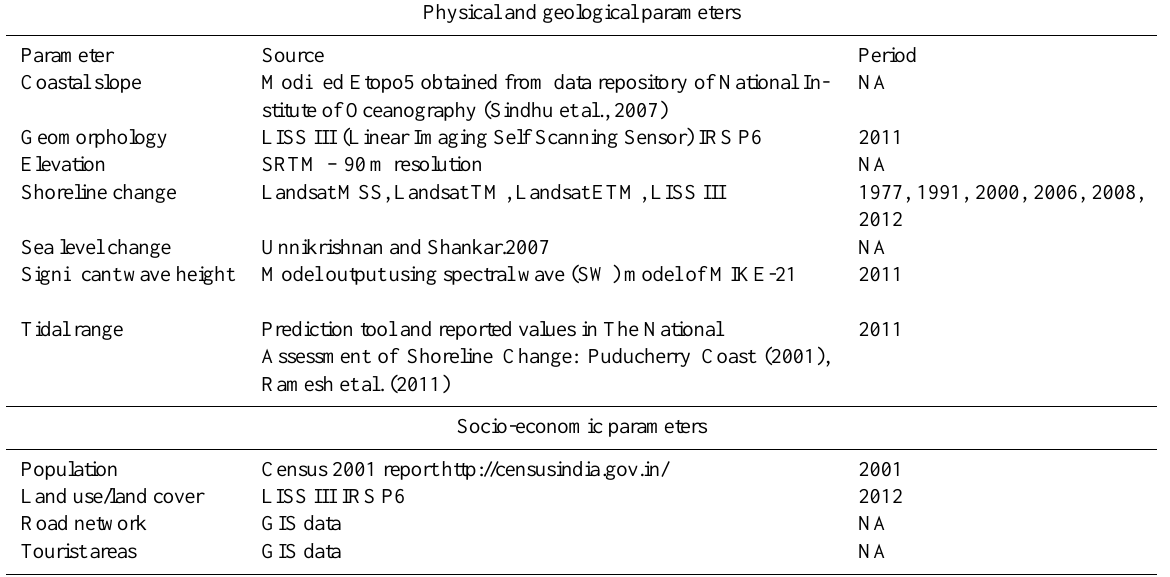
Table 1. Data used for the study.